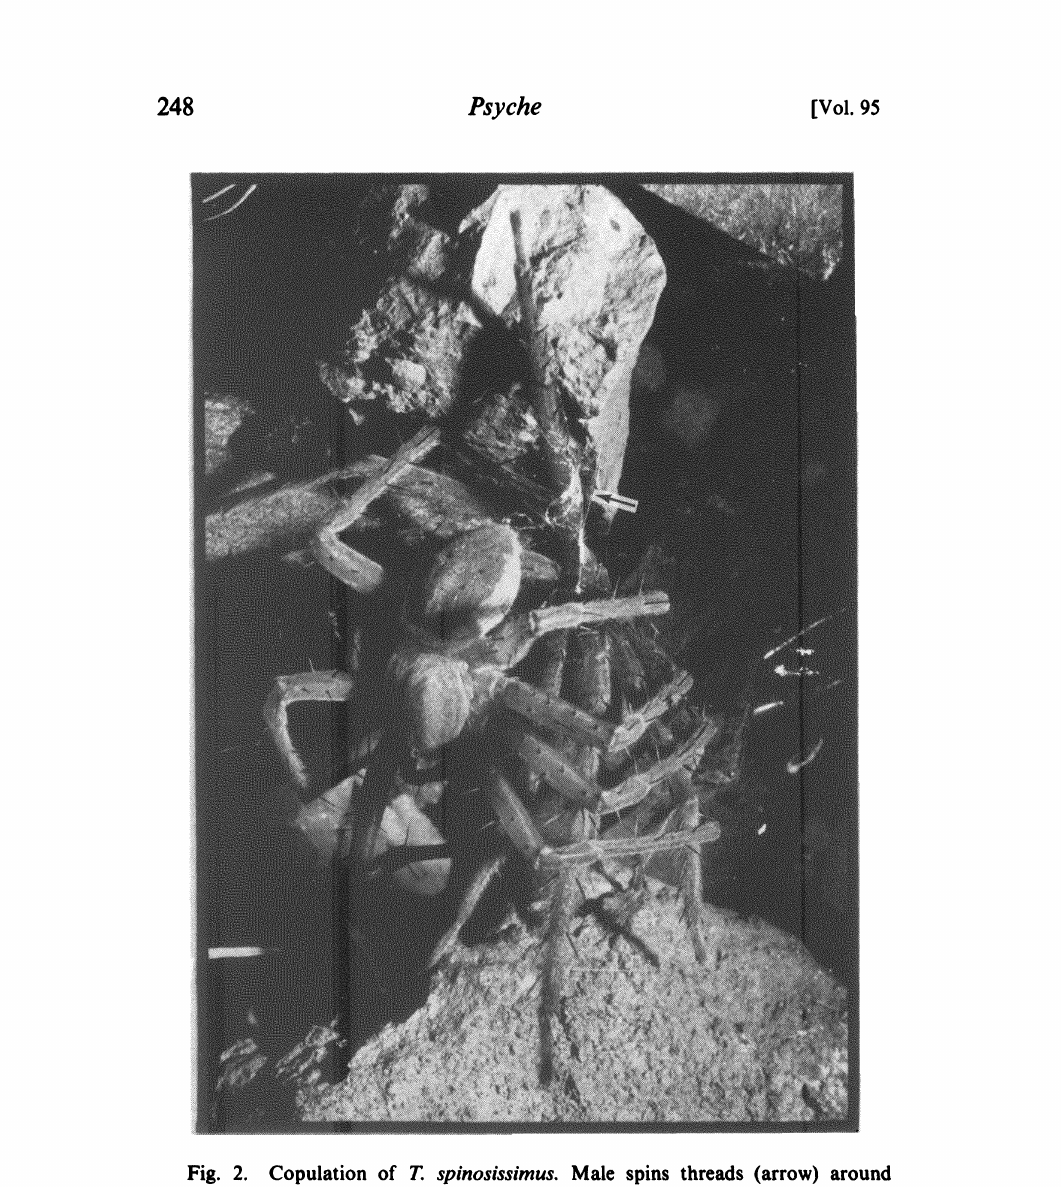
Fig. 2. Copulation of T. spinosissimus. Male spins threads (arrow) around female’s